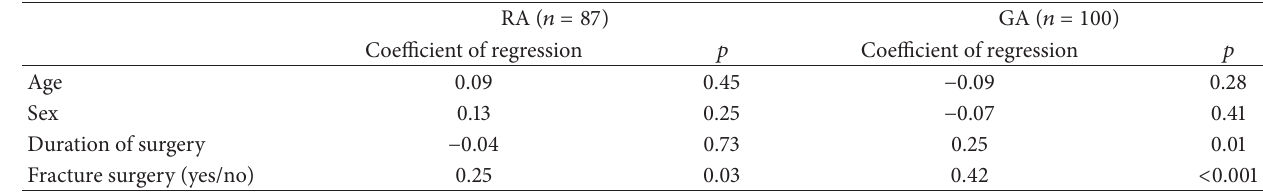
Median (IQR). PACU, Postanaesthesia Care Unit. LOS, length of stay. Table 5: Multiple regressions on PACU length of stay for subgroups RA and